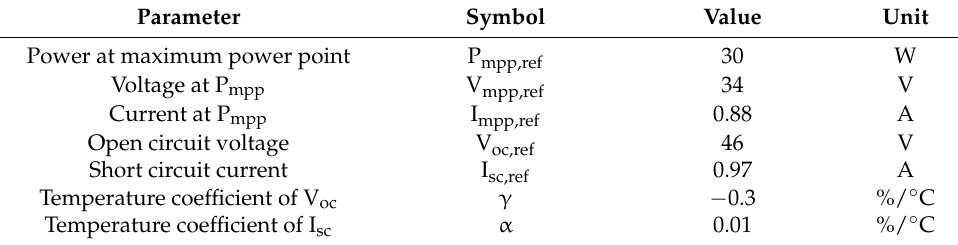
Table 8. Electrical parameters of PV